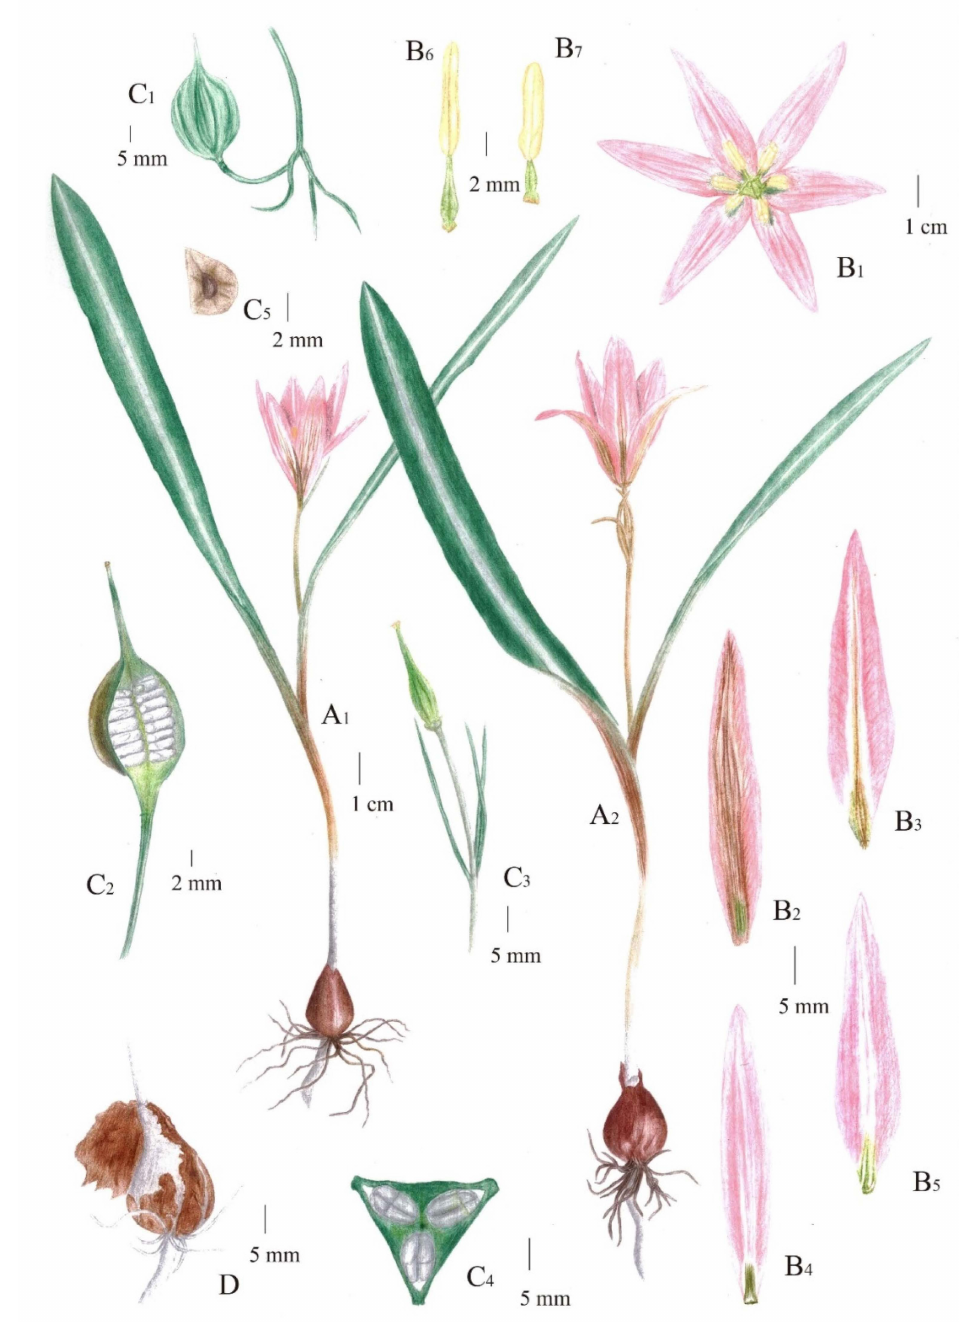
Figure 3. Illustration of Amana hejiaqingii ( A1 , A2 ) Flowering plants, ( B1 ) Flower, ( B2 ) Abaxial surface of outer tepal, ( B3 ) Abaxial surface of inner tepal, ( B4 ) Adaxial surface of outer tepal, ( B5 ) Adaxial surface of inner tepal, ( B6 ) Outer stamen, ( B7 ) Inner stamen, ( C1 ) Fruit, ( C2 ) Longitudinal section of ovary, ( C3 ) Immature capsule and bracts, ( C4 ) Transverse section of ovary, ( C5 ) Seed, ( D ) Bulb. Drawn by Xin-Jie